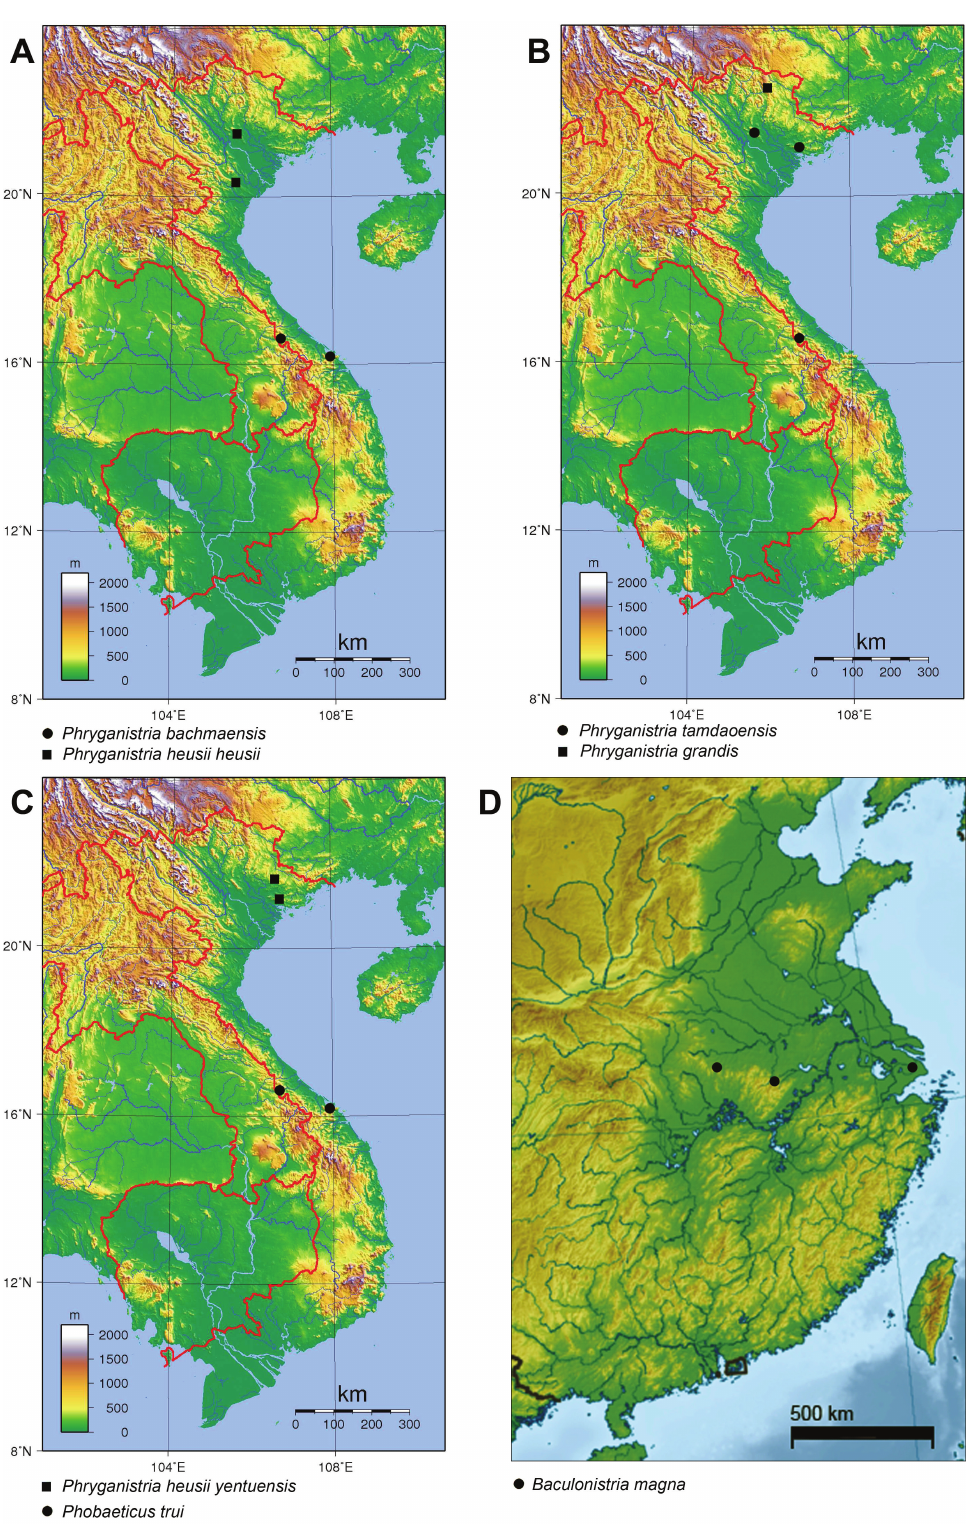
Fig. 12. Distribution maps. A . Phryganistria bachmaensis (Ta & Hoang, 2004) comb. nov. and P. heusii heusii (Hennemann & Conle, 1997). B . P. tamdaoensis sp. nov. and P. grandis Rehn, 1906. C . Phryganistria heusii yentuensis subsp. nov. and Phobaeticus trui sp. nov. D . Baculonistria magna (Brunner von Wattenwyl, 1907) comb.